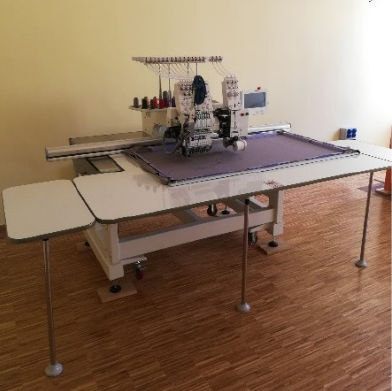
Figure 14. The FT-1201+1PD computer embroidery machine, Fortever.